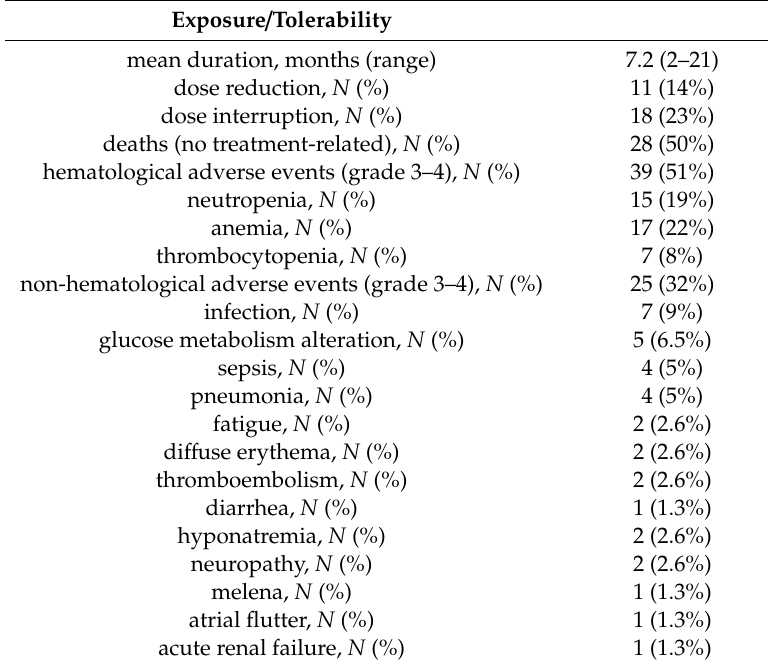
Table 3. Tolerability, treatment exposure, and adverse events in relapsed / refractory MM (RRMM) patients treated with